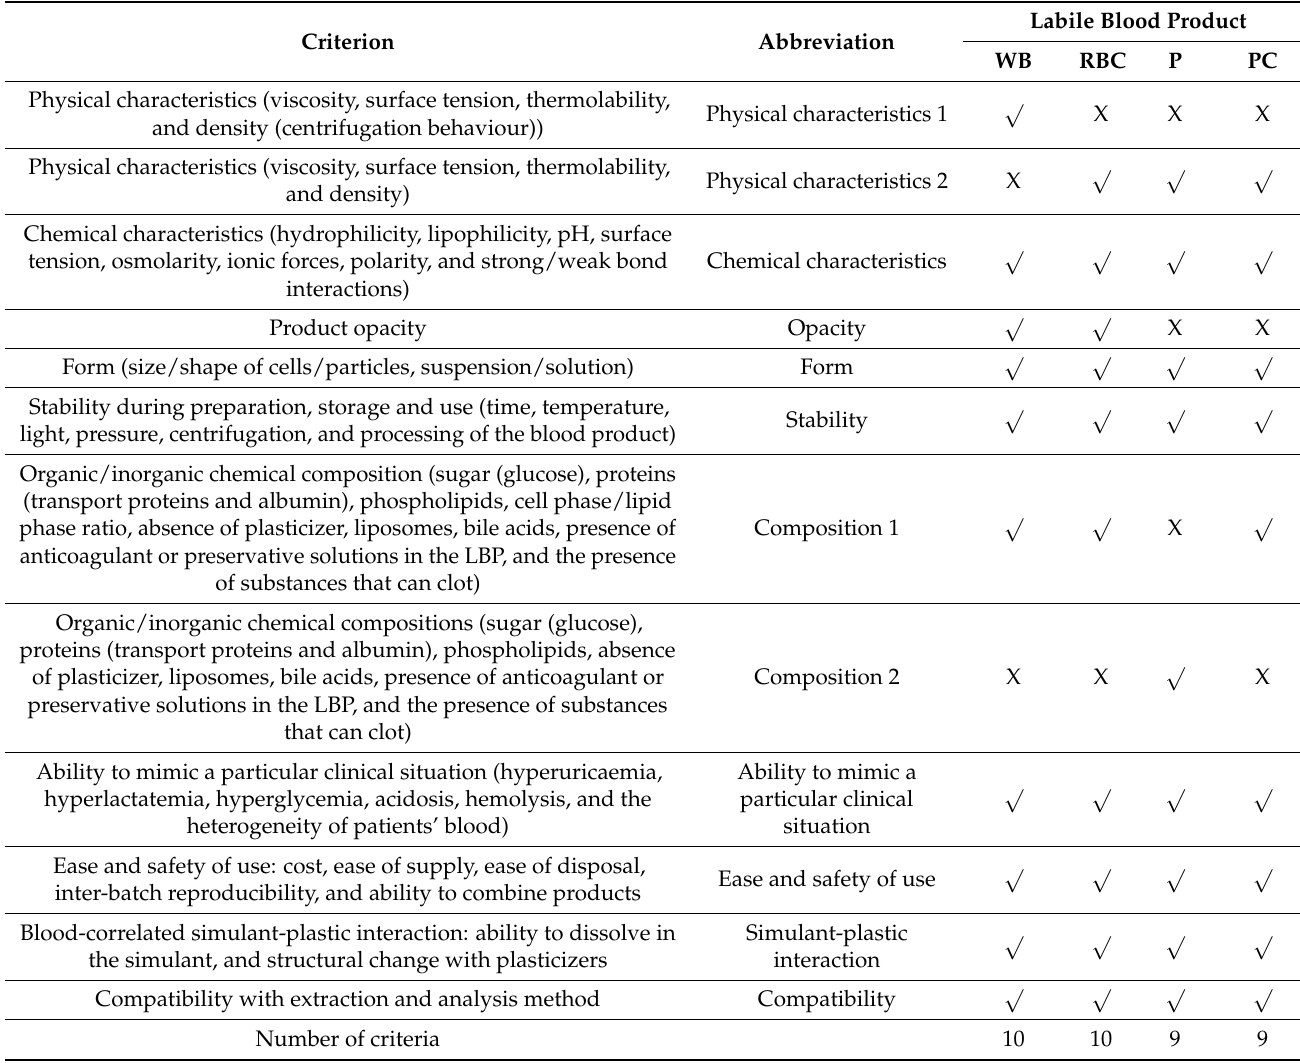
Table 3. Reformulated criteria suggested by the experts in the nominal group for each LBP.